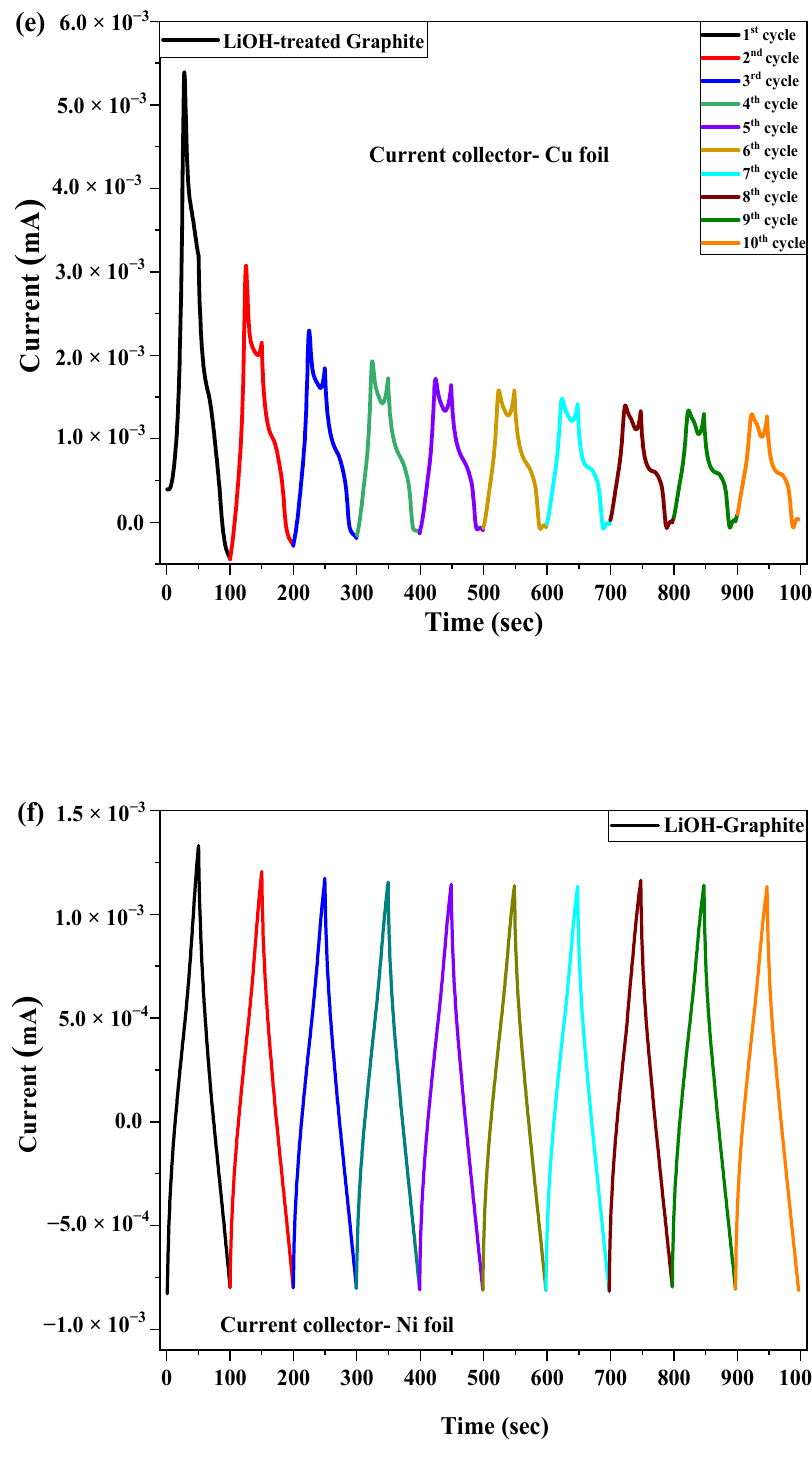
Figure 11. Stability test of LiOH-treated YP80F, YP50F and graphite (Cu-foil and Ni-foil current collector and 5% KOH electrolyte). ( a ) LiOH-YP80F with Cu-foil; ( b ) LiOH-YP80F with Ni-foil; ( c ) LiOH-YP50F with Cu-foil; ( d ) LiOH-YP50F with Ni-foil; ( e ) LiOH-Graphite with Cu-foil; ( f ) LiOH-Graphite with Ni-foil.